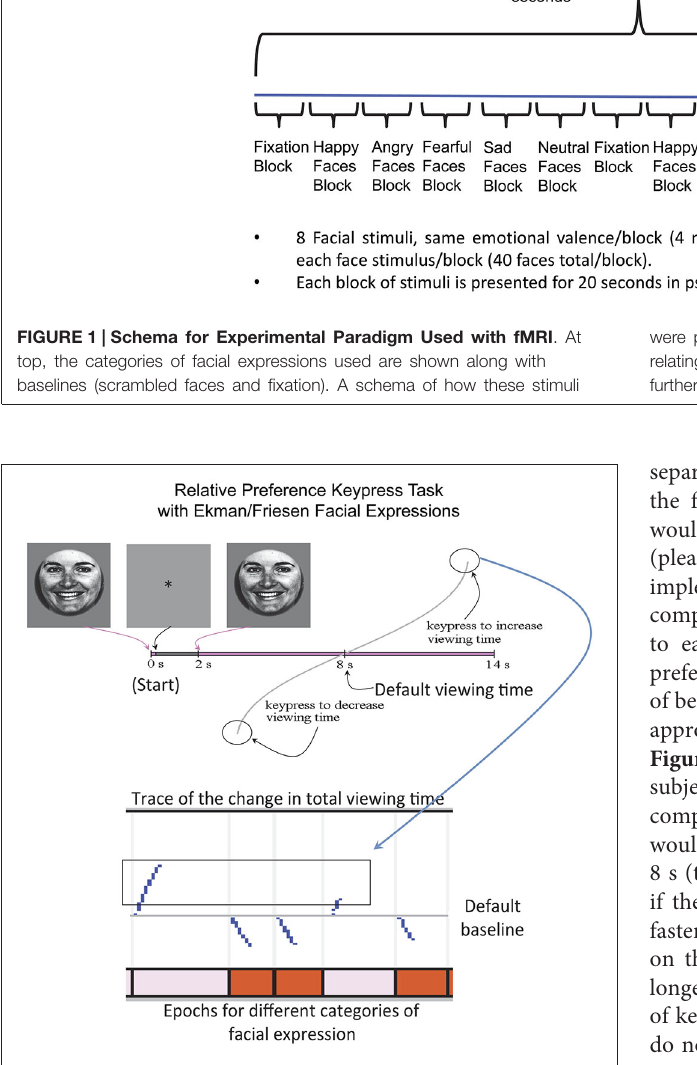
FIGURE 2 | Keypress Paradigm . The behavioral task done outside the MRI to minimize motor confounds to activation is schematized above, with an example raster plot